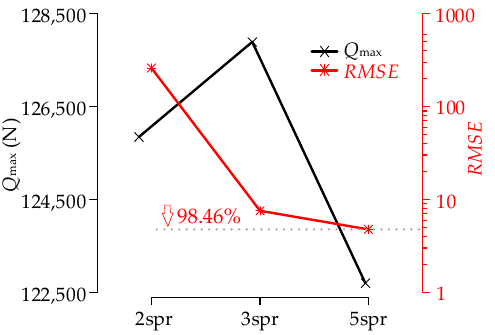
Figure 24. Maximum roller load vs. RMSE of maximum equivalent roller load.